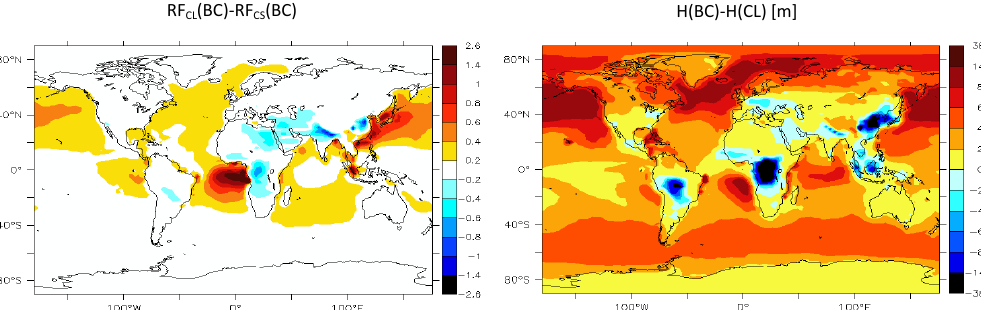
Fig. 7. Left panel: difference between cloudy- and clear-sky BC forcing (RF CL (BC) [Wm − 2 ], RF CS (BC) [Wm − 2 ]) for the AIB experiment. Right panel: characteristic height (see text for definition) of BC optical depth ( H (BC) [m]) minus characteristic height of cloud optical depth ( H (CL) [m]). The differences in heights are multiplied by the monthly product of the 2-D BC optical depth and the 2-D cloud